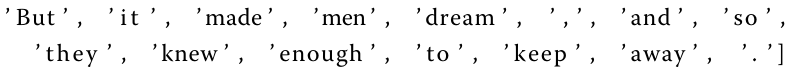
The original text and the tokens are shown below. The corresponding TRS is shown in Fig.